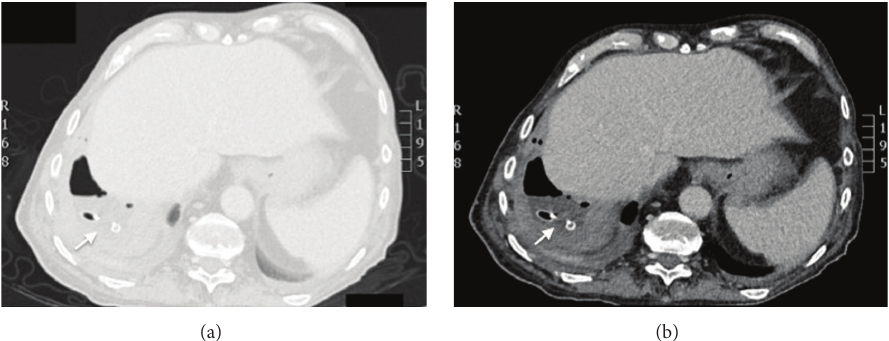
Figure 3: Computed tomography. Pigtail catheter correctly placed in the right lower lobe.